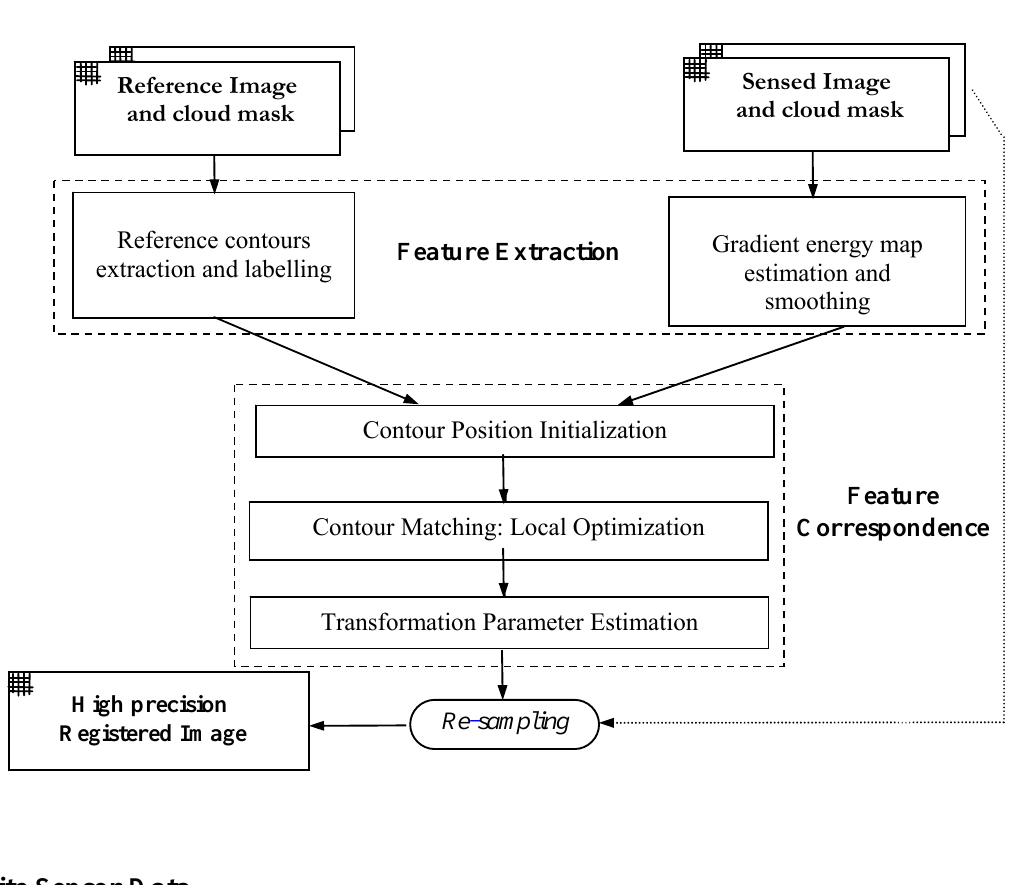
Figure 1. Schematic procedure of the proposed automatic satellite imagery